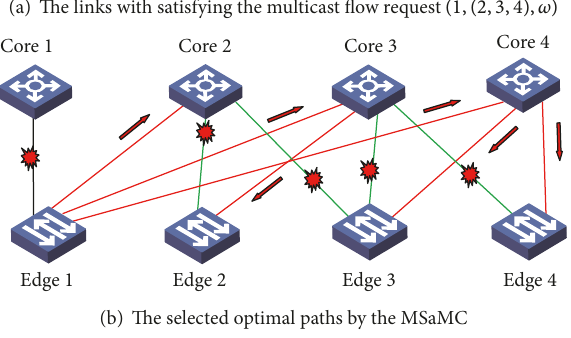
Figure 5: An example of the